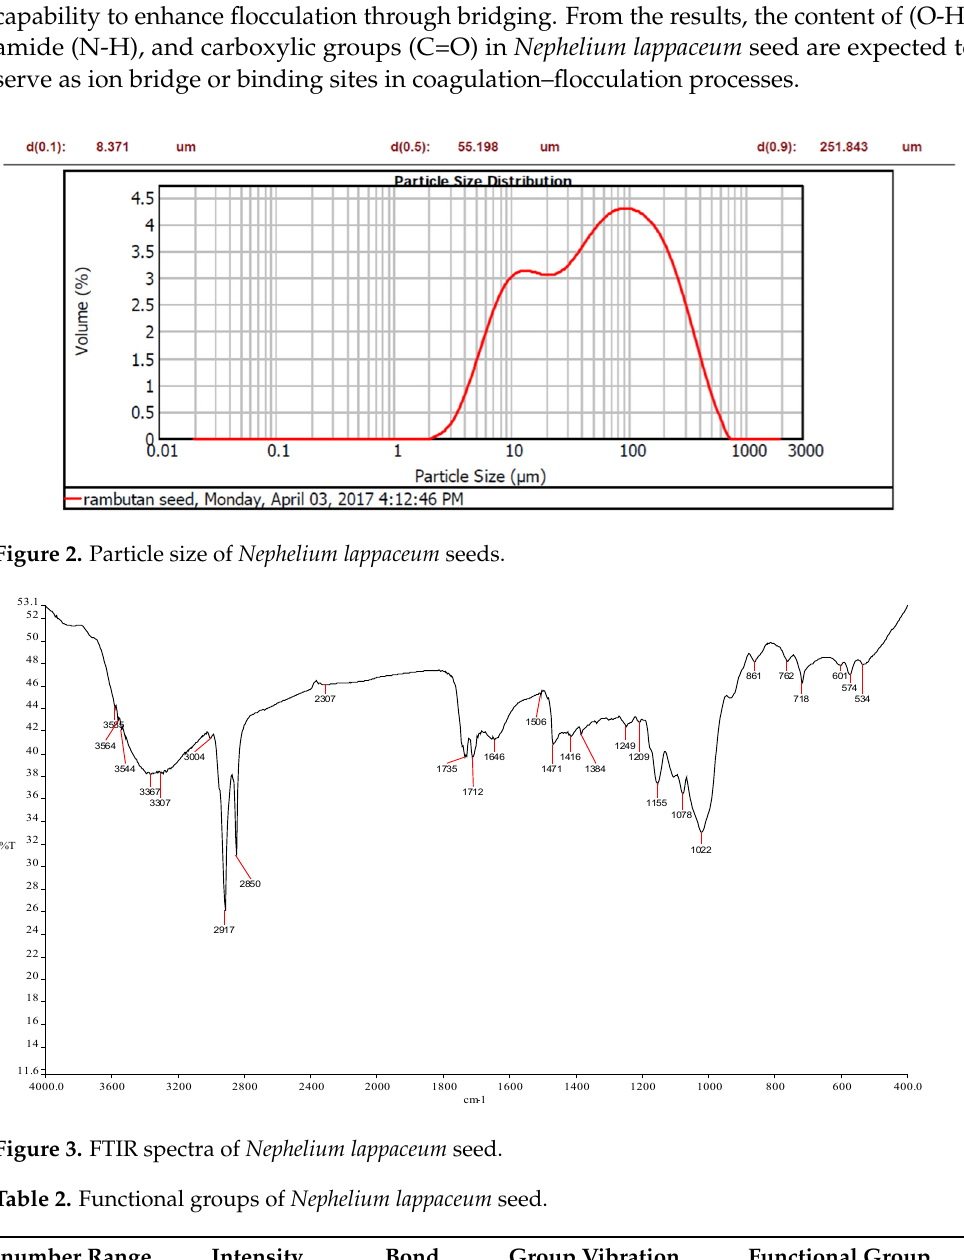
Figure 2. Particle size of Nephelium lappaceum seeds.